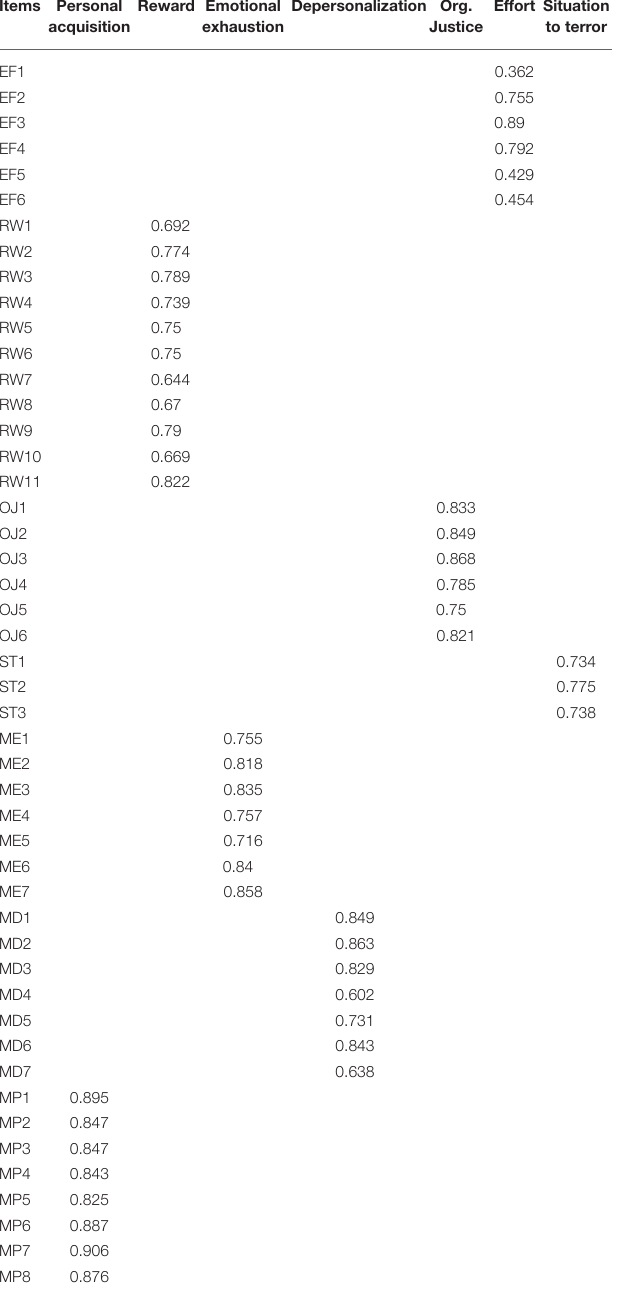
TABLE 2 | Pattern matrix. Items Personal Reward Emotional Depersonalization Org. acquisition exhaustion